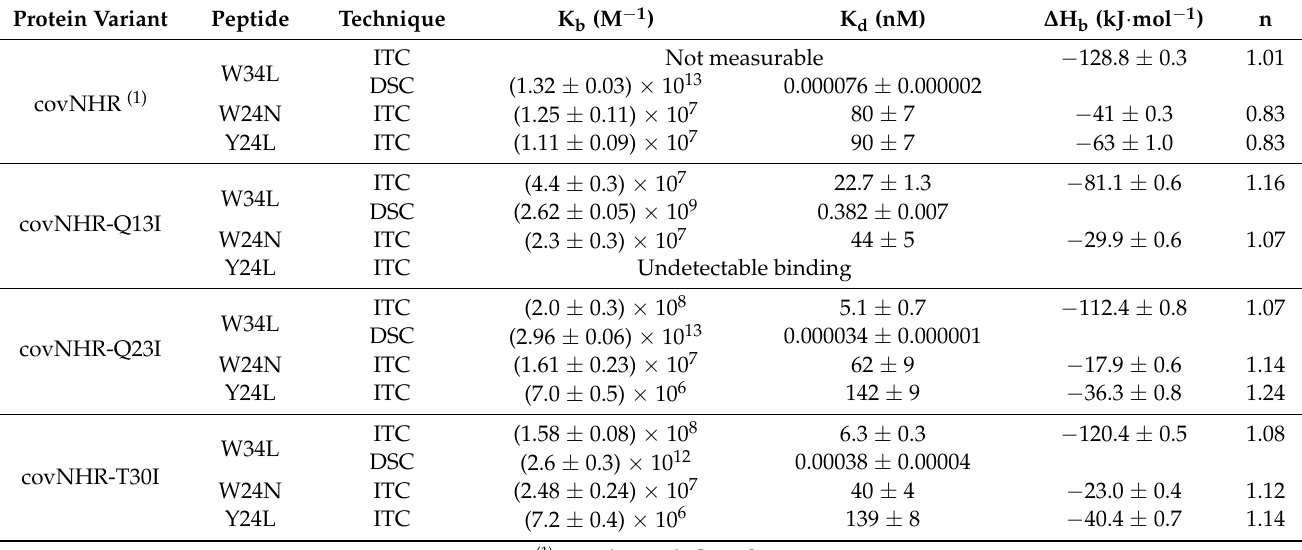
Table 1. Thermodynamic parameters of binding of gp41 CHR peptides to the covNHR proteins determined by isothermal titration calorimetry (ITC) or differential scanning calorimetry (DSC). Protein Variant